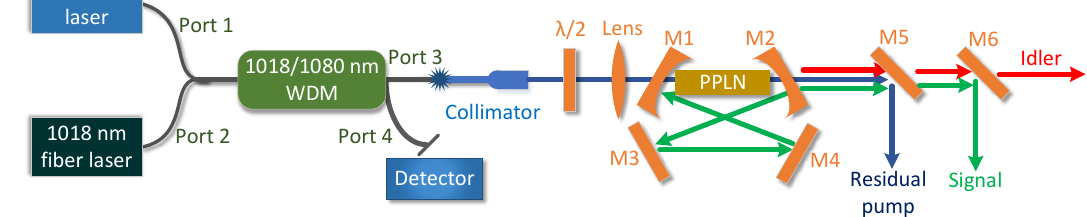
Figure 1. Schematic diagram of the frequency down-conversion of single-frequency (SF) fiber source using intracavity difference frequency generation (DFG).